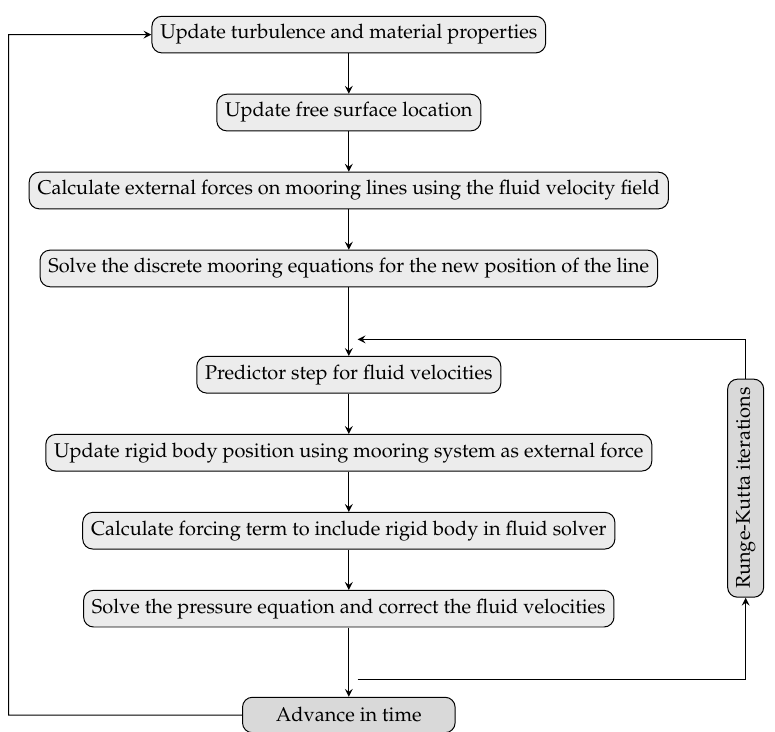
Figure 2. Flowchart of the algorithm to simulate the fluid–structure interaction of moored, floating structures in